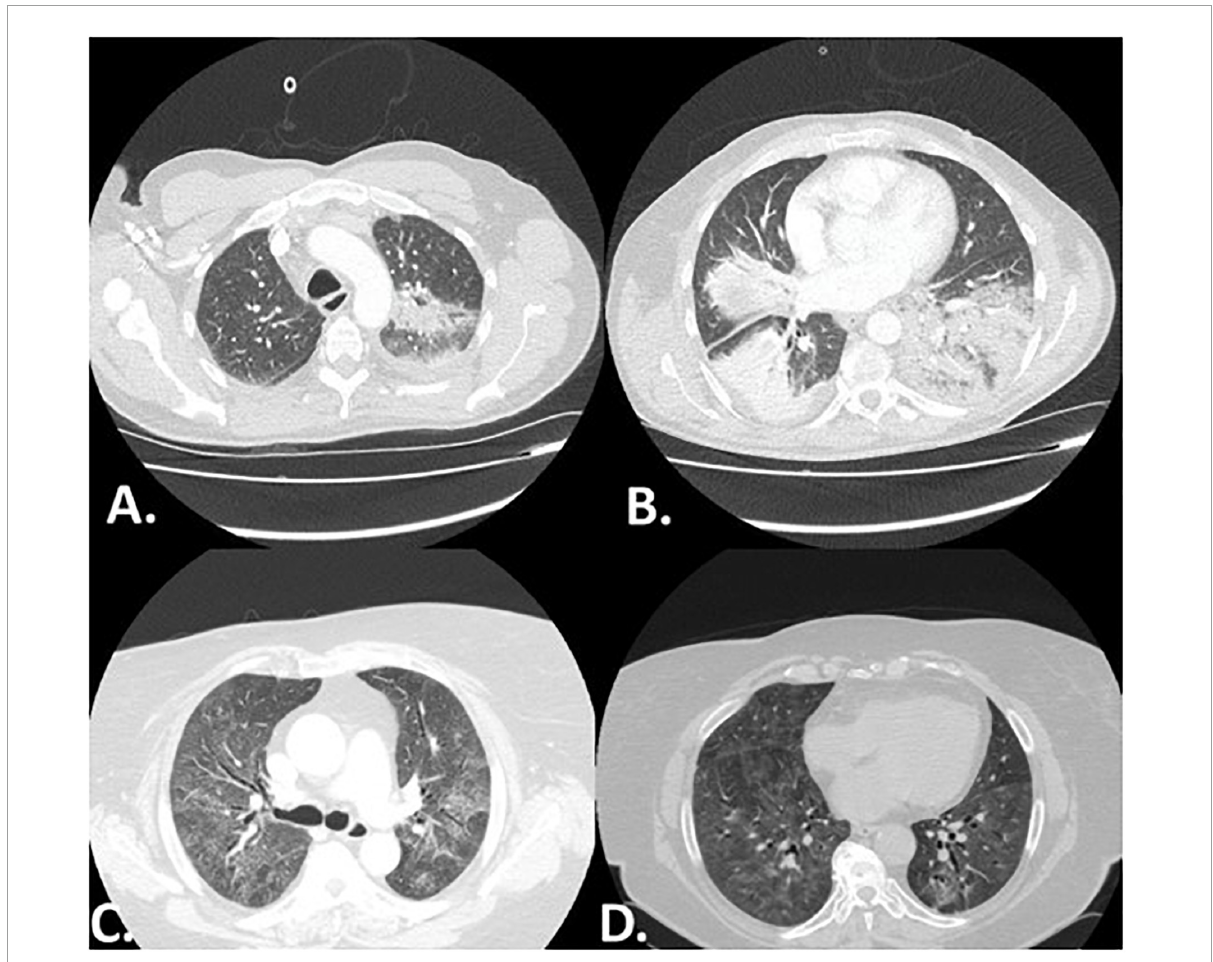
FIGURE1 Representative high resolution computed tomography (HRCT) images of two patients with myositis associated-ILD. Panel (A,B) depict a patient with RP-ILD presenting with the radiographic pattern of organizing pneumonia. Panel (C,D) present a case of myositis in which non-specific interstitial pneumonia (NSIP) was observed 10 years following diagnosis.